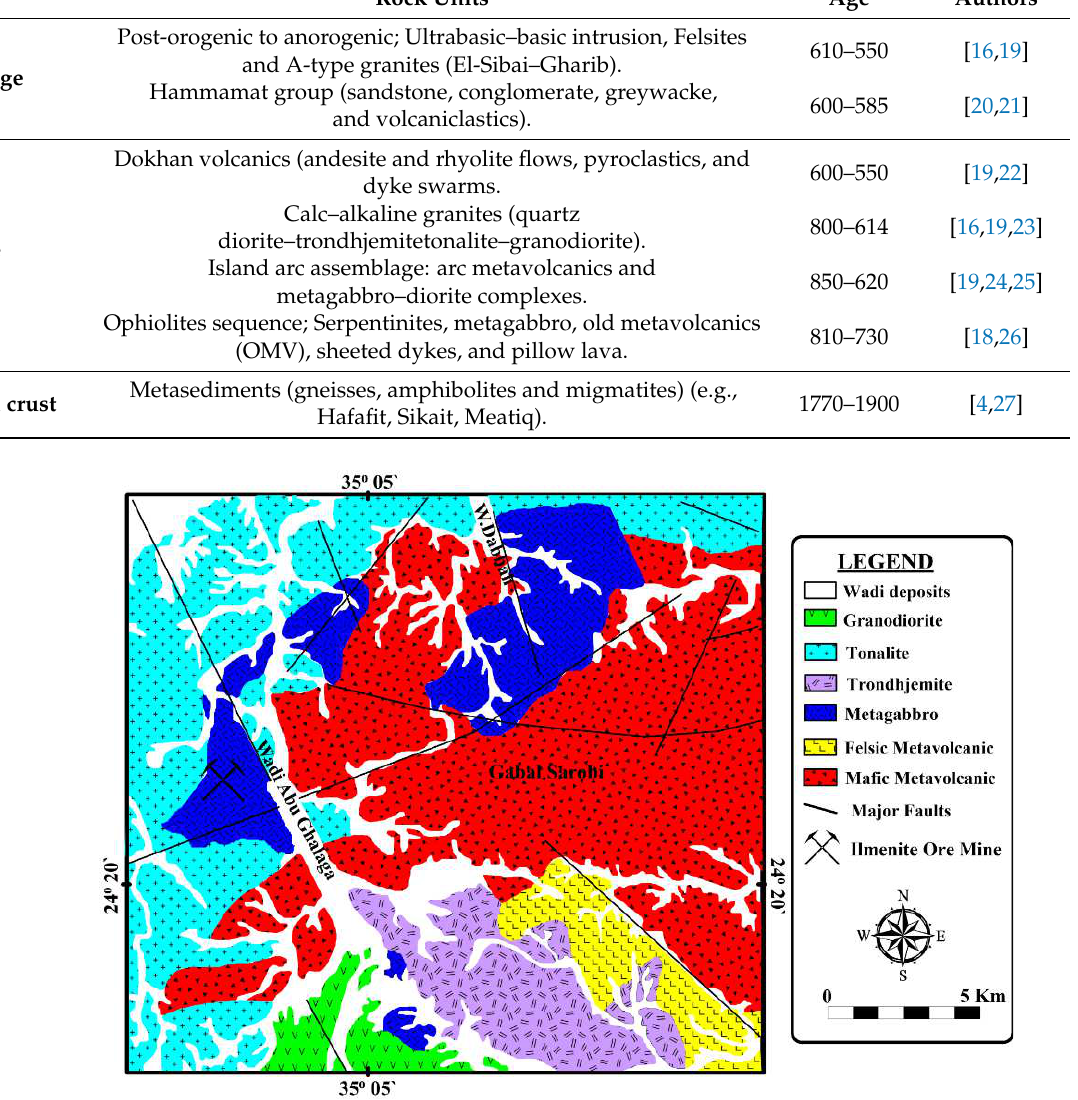
Figure 2. Detailed geologic map of Wadi Abu Ghalaga district [11]